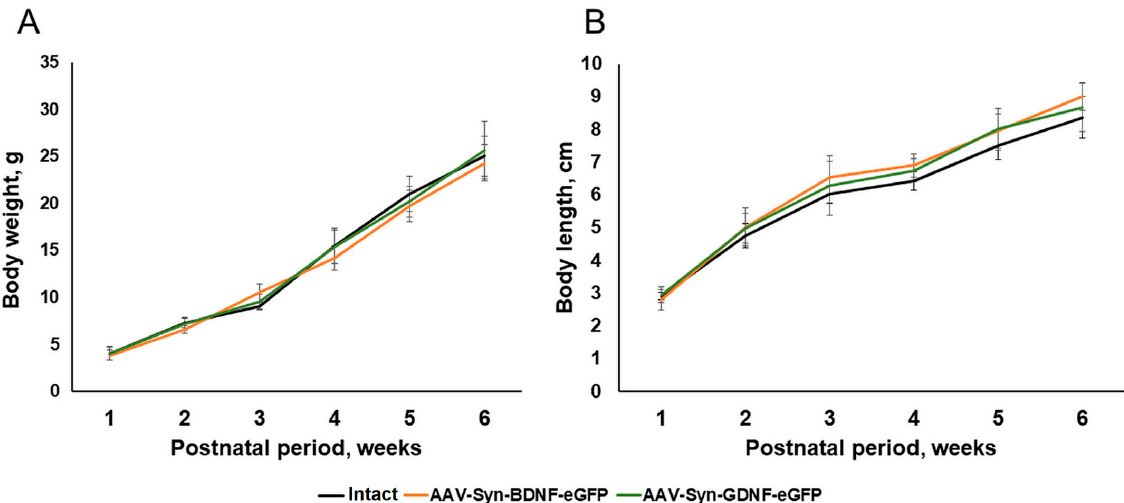
Figure 3. Dynamics of changes in morphometric parameters of male C57BL/6 mice after AAV-Syn- BDNF-eGFP and AAV-Syn-GDNF-eGFP transduction. ( A ) the dynamics of changes in the weight of mice within six weeks after the injection of the AAV-constructs; ( B ) the dynamics of changes in the body length of mice within six weeks after the injection of the AAV-constructs. No statistically significant differences between groups. Table 1. Evaluation of neurological status of male C57BL/6 mice 30 days after AAV-Syn-BDNF-eGFP and AAV-Syn-GDNF-eGFP transduction. Group of